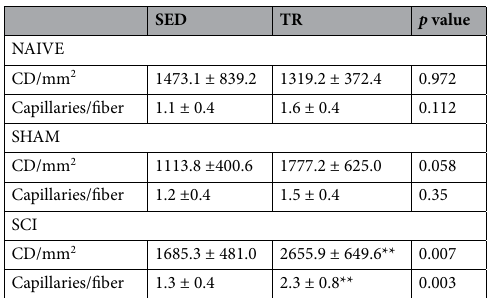
Table 2. Soleus muscle capillarization. Values are means ± SD for NAIVE, SHAM and SCI (SED and TR). Training effect between SED and TR groups ** p < 0.01.